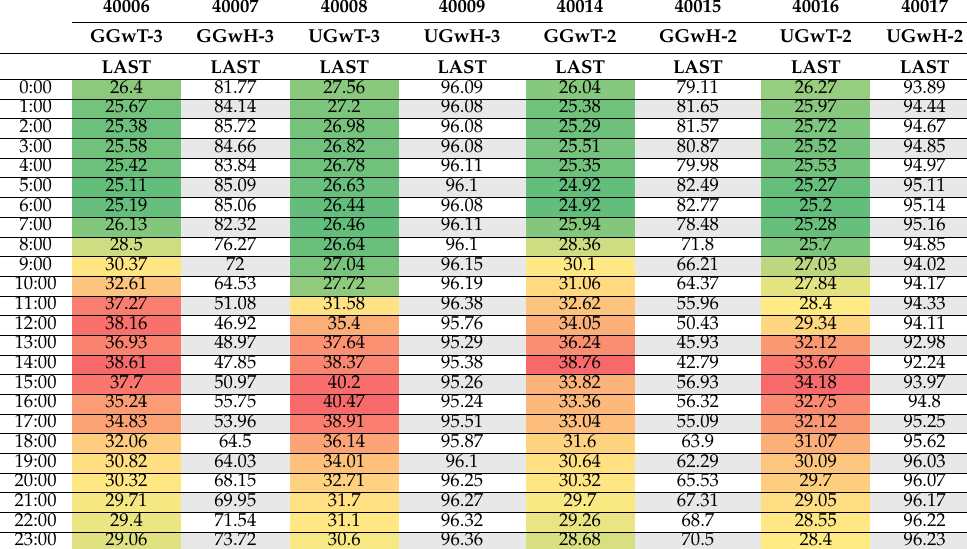
Figure 6c, in that 1-week interval, the trends of the GGwT 2 , UGwT 2 , and the CWB Taipei Station curves were similar. Table 10 lists the pairwise comparison of the similarities of the curves. The other site was the permeable brick pavement near the Zhongxiao Gate. The temperature and humidity trend from 16 May to 22 May are presented in Figure 6d. The peak of the curve occurred at approximately 2:00 p.m. Table 9. Regions C and D: Temperature changes in the permeable brick pavement.